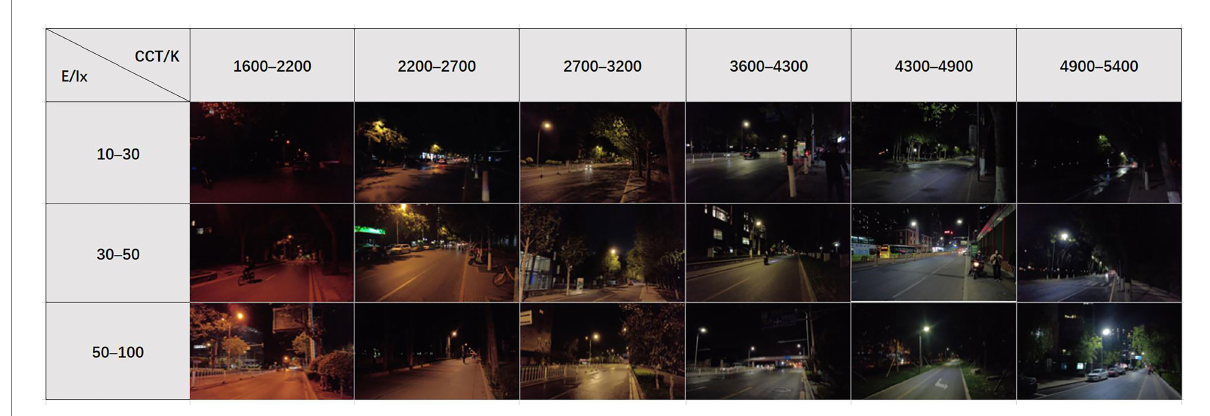
FIGURE 3 Images of streets with different CCT and illuminance combinations (shot in April to May 2021, 19–21